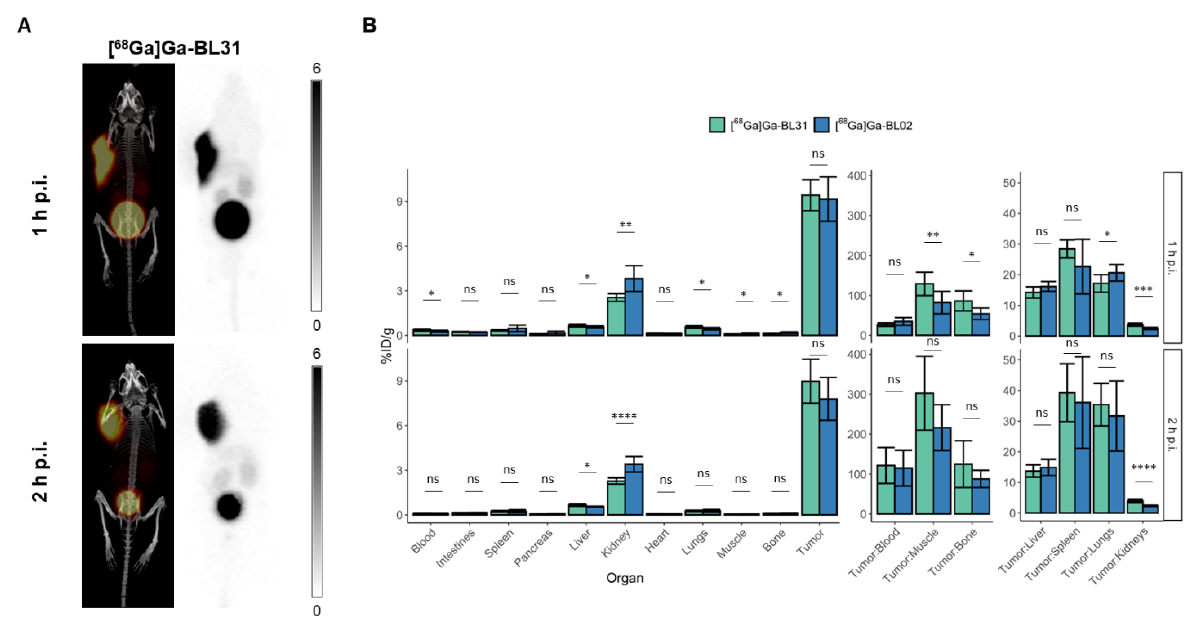
Figure 4. ( A ) Maximum intensity projections for PET/CT and PET alone at 1 and 2 h p.i. of [ 68 Ga]Ga- BL31. Scales of the PET images of [ 68 Ga]Ga-BL31 are 0–6 %ID/g. ( B ) Ex vivo biodistribution data of [ 68 Ga]Ga-BL31 in comparison to that of [ 68 Ga]Ga-BL02 in Daudi xenograft-bearing mice at 1 and 2 h p.i. ( p < 0.05 = *, p < 0.01 = **, p < 0.001 = ***, p < 0.0001 = ****, ns = not significant).